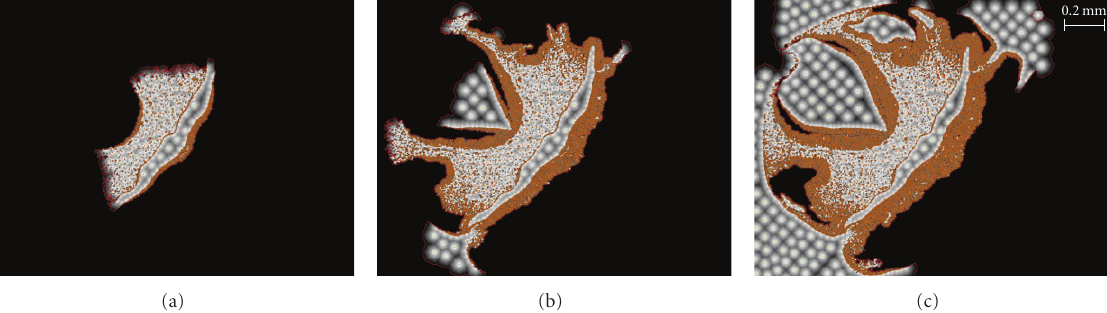
Figure 4: ICS progress. The 3 frames above show how ICS searches through an image over time. The algorithm starts from the center of the image where the first search seed was placed (first frame). For each frame, orange regions (more visible in the second and third frames) represent regions with positive cell locations, and white regions represent regions where no cells were found. The regions covered by the algorithm are enclosed by a thin red boundary, and the dark regions have not yet been explored by the algorithm.